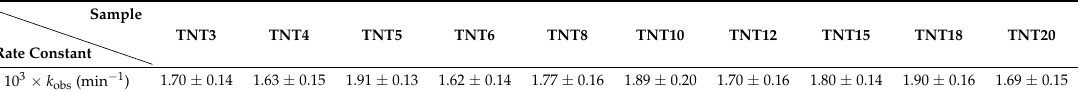
Table 2. The k obs rate constants for methylene blue (MB) photodegradation on the TNT surfaces formed at different potentials. The results take into account blind tests (no UV and no titania